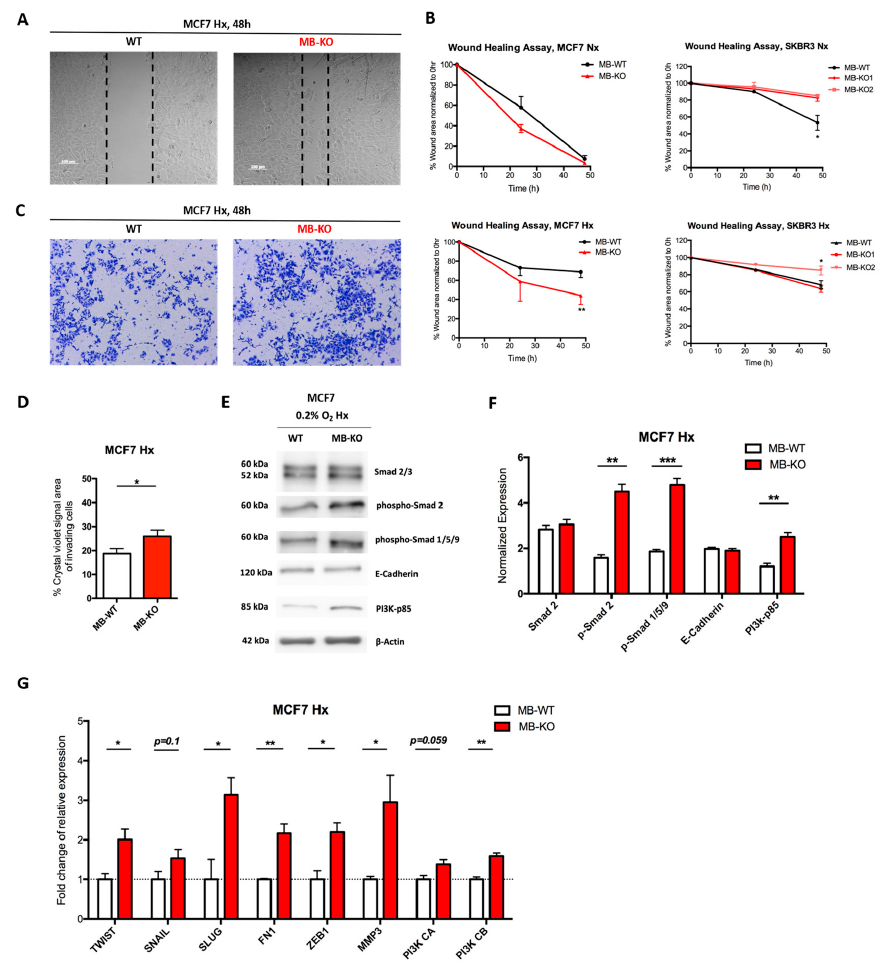
Figure 2. Loss of myoglobin increases the migratory capacity of hypoxic MCF7 cancer cells ( A ) Representative images of wound healing assay for MCF7 clones grown at 0.2% O 2 hypoxia (Hx) in serum reduced medium for 48 h. A scratch was initiated into a monolayer of each cell line and cells were incubated in normoxia (Nx) or 0.2% O 2 Hx. The % of the scratch area was measured and calculated after 24 and 48 h ( n = 3). ( B ) Scatter plot of % scratch area (normalized to 0 h) against the time of incubation. MCF7 (left panels) and SKBR3 (right panels) wildtype (MB-WT, white) and MB knockout (MB-KO, red) clones ( n = 3). ( C ) Representative images of Transwell invasion assay showing only invading wildtype and MB-KO MCF7 cells through a layer of Matrigel after culturing at 0.2% O 2 Hx in Transwell for 48 h followed by fixation/staining with 0.6% glutaraldehyde and crystal violet solution. Magnification is 5x. ( D ) Quantitative representation of % of crystal violet signal area of invading cells of MB-WT (white) and MB-KO (red) of MCF7. Five random images from each well were captured and analyzed by ImageJ and the average of the signal area was calculated ( n = 3). ( E ) Representative Western blotting image ( n = 3) of whole tissue lysate of MB-WT and MB-KO clones of MCF7 cells cultured at 0.2% O 2 Hx for 72 h and stained for Smad2/3 (60 and 52 kDa, respectively phospho-Smad2 (60 kDa phospho-Smad 1/5/9 (60 kDa), E-Cadherin (120 kDa), PI3K-p85 (85 kDa), and β -actin (42 kDa) used as the loading control. ( F ) Band intensity of Smad2, phospho-Smad2, phospho-Smad 1/5/9, E-Cadherin, and PI3K-p85 proteins after Western blotting, from MB-WT (white bars) and MB-KO (red bars) cells at 0.2% O 2 Hx, was quantified using MCID Analysis 7.0 and normalized to β -actin ( n = 3). ( G ) Relative mRNA expression levels of genes that regulate epithelial to mesenchymal transition: TWIST, SNAIL, SLUG, FN1, ZEB1, MMP3, PI3K CA, and Pi3K CB , quantified by qPCR and normalized to β -actin ( ACTB ) mRNA expression levels, from MB-WT (white) and MB-KO (red) clones of MCF7 cells cultured at 0.2% O 2 Hx for 72 h. ( n = 3 per group). Data are presented as mean and standard error of mean and analyzed by Student’s t -test * p < 0.05; ** p < 0.01, *** p <